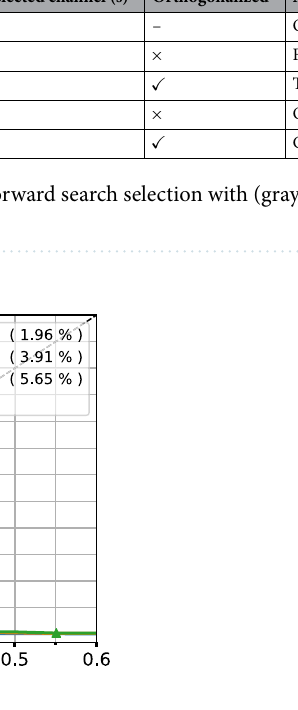
No. of channel(s) (step of forward search selection) Previously selected channel (s) Orthogonalized Next channel Accuracy (%)